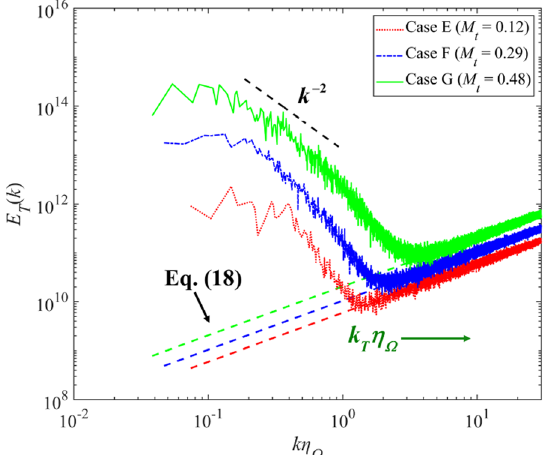
3 . The spectra of thermal =